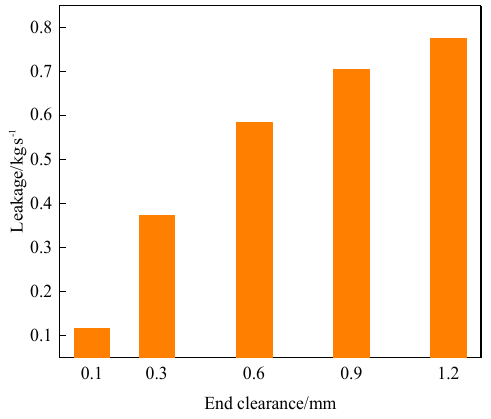
Figure 10. Leakage of different end clearance.